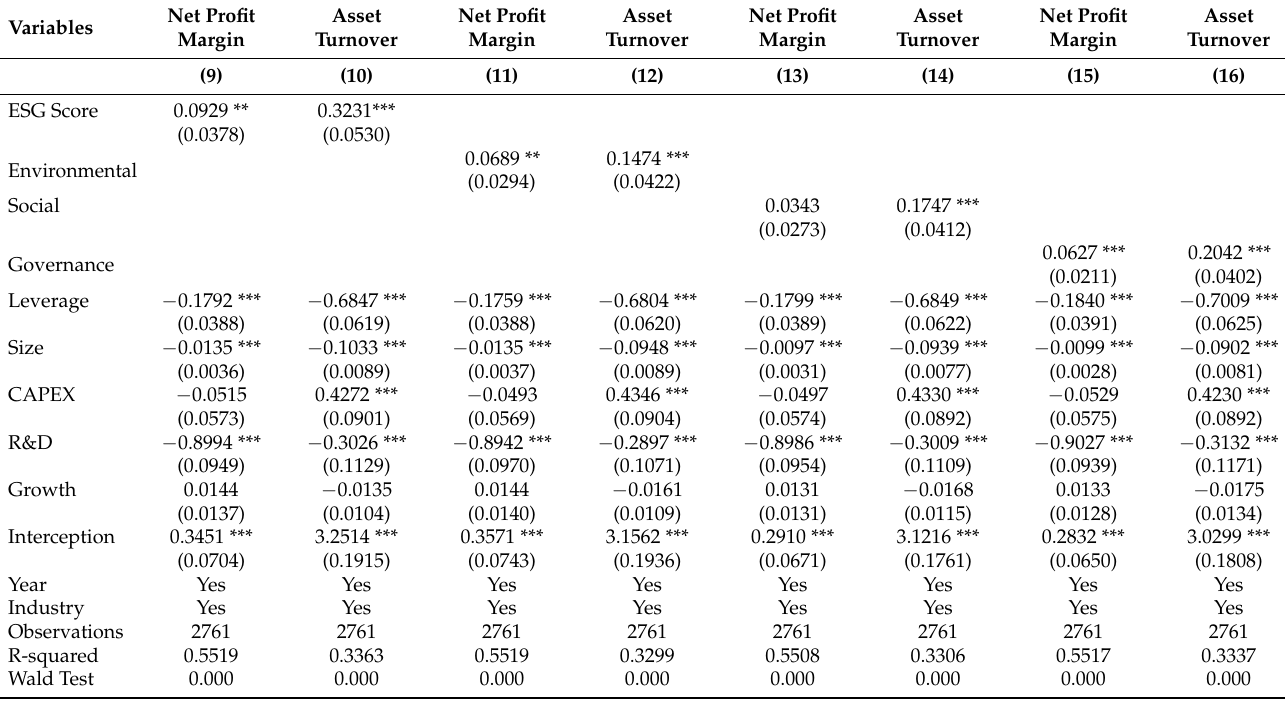
Table 5. OLS regressions: channels of economic